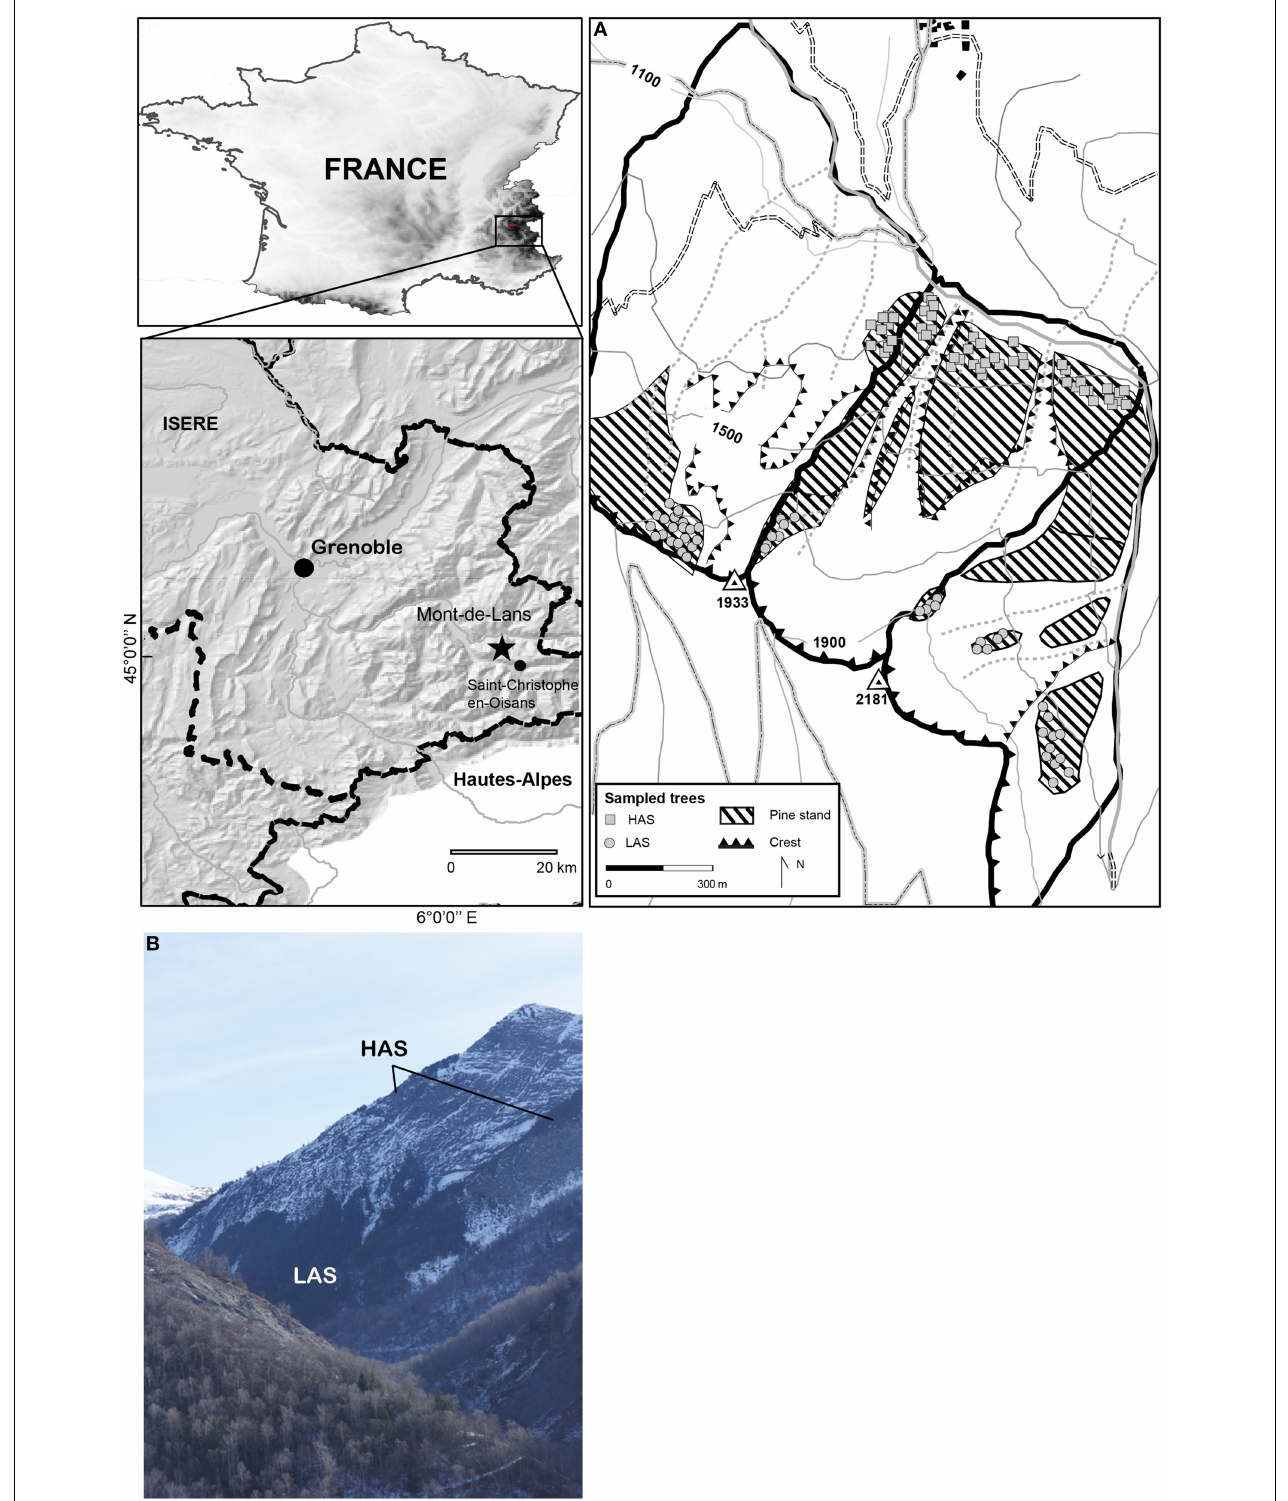
FIGURE 1 | (A) Location of the Grande Aiguille study site in the Northern French Alps; (B) Impressions of low (LAS) and high (HAS) altitude P. uncinata stands.